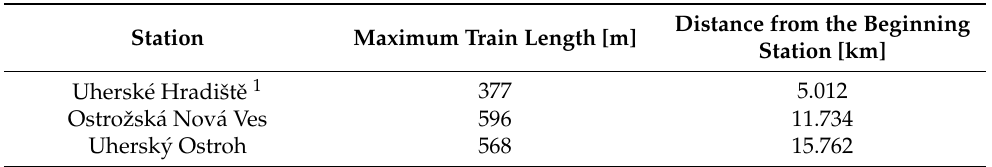
Table 3. Intermediate stations of the single-track section of the line 340 Star é Mˇesto u U. H.–Brno (data: [1,23,28]). Source: